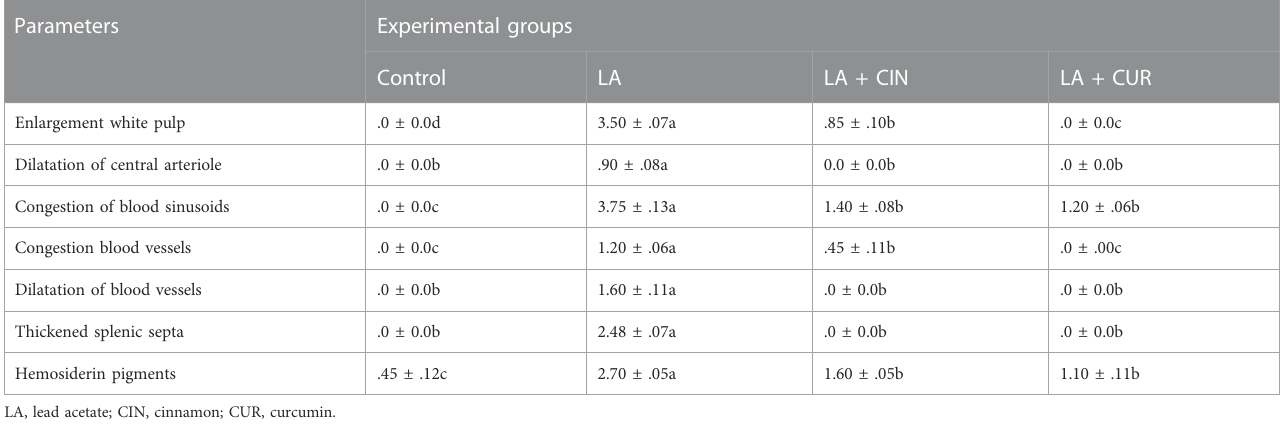
TABLE 2 Ordinal scoring of splenic histological changes among different groups.